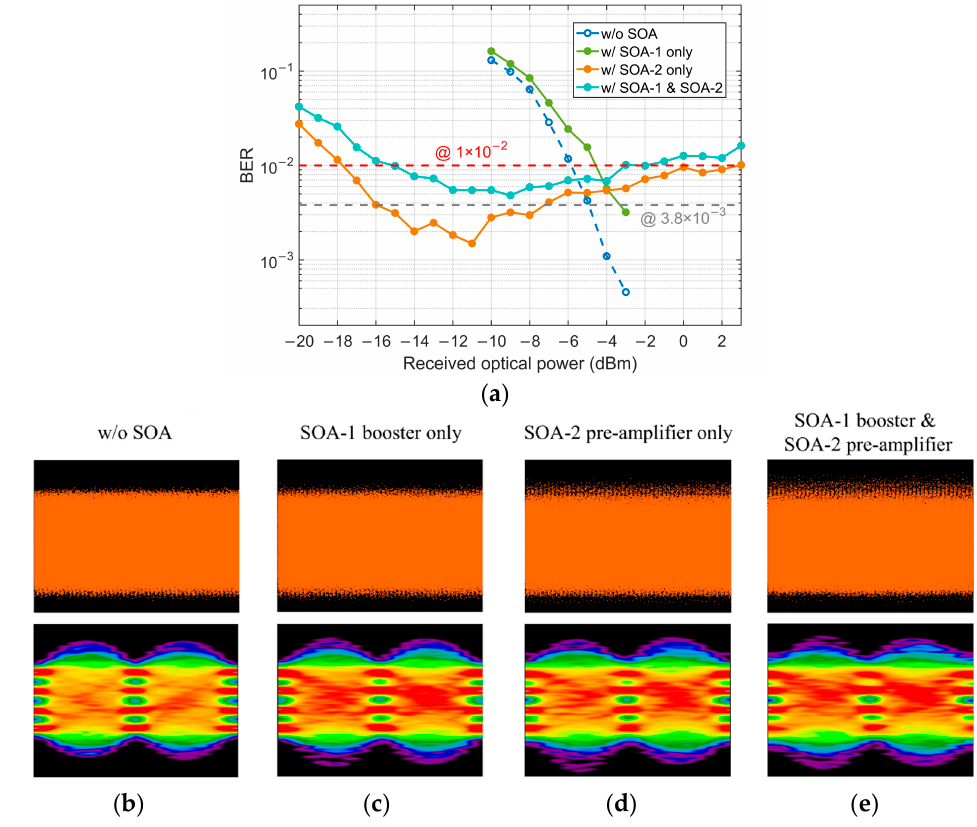
Figure 4. ( a ) BER performance under four conditions: without SOA, with SOA-1 only, with SOA-2 only, and with both SOA-1 and SOA-2; ( b – e ) Corresponding receiver time-domain signals and FFE recovered eye diagram at − 3 dBm ROP.